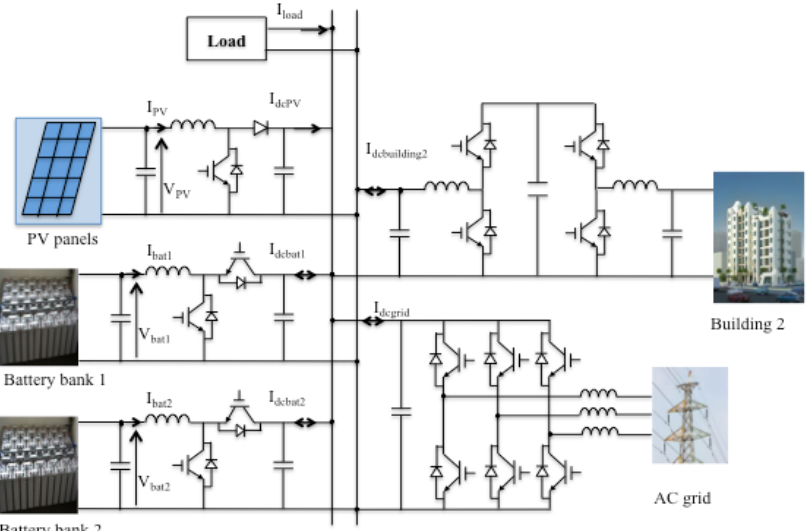
Figure 2. DC microgrid configuration of a building.